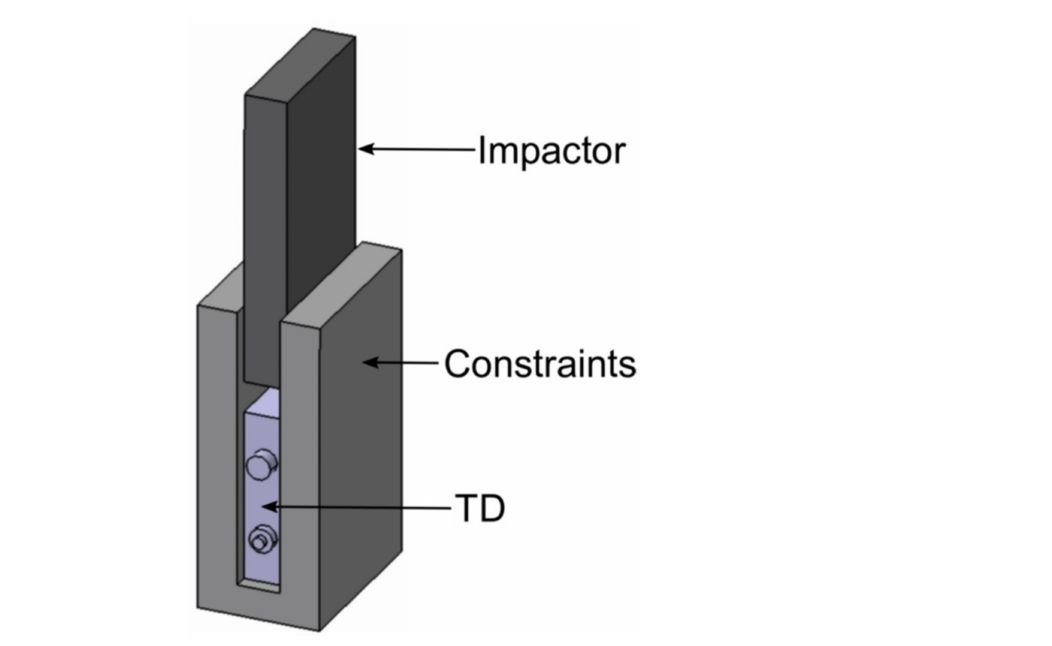
Figure 5. Prismatic cell in the fixture and crushed along Z-orientation as per SAND2017- 6925:2017